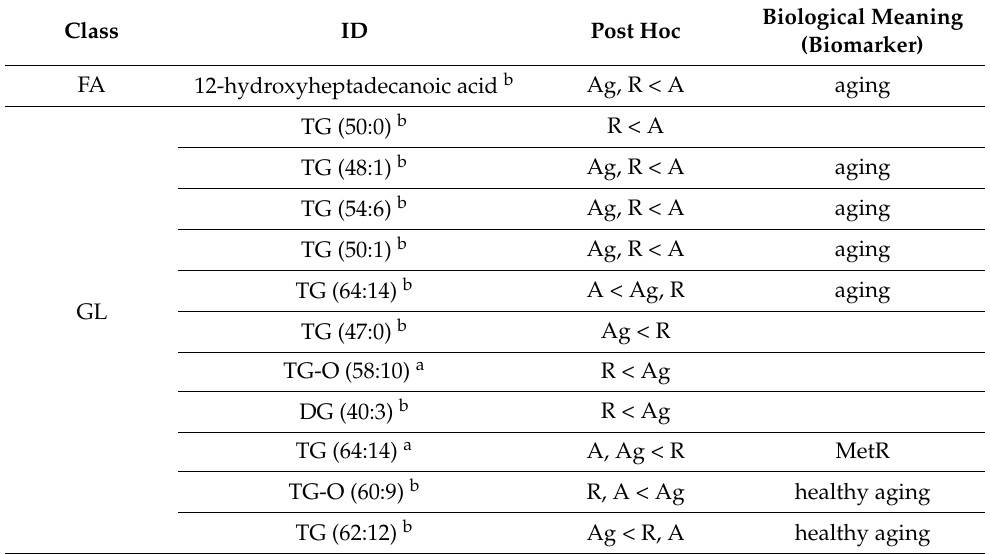
Table 5. Lipid species significantly different between experimental groups in the rat frontal